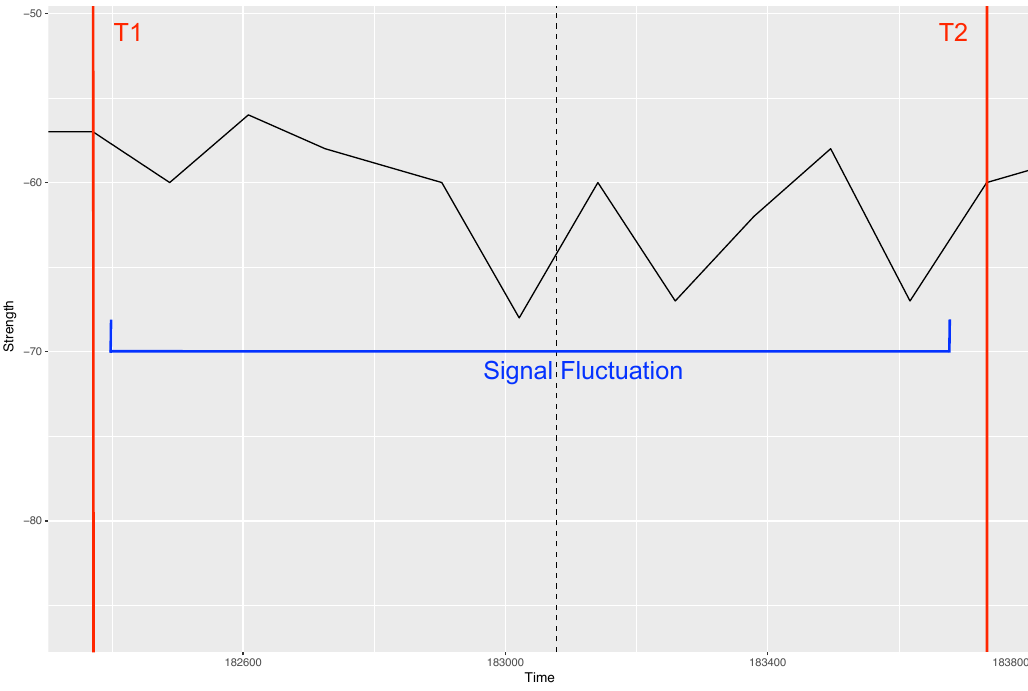
Figure 6. Illustration of time window and associated signal fluctuation pattern identification (Units: Time = Milliseconds, Strength =